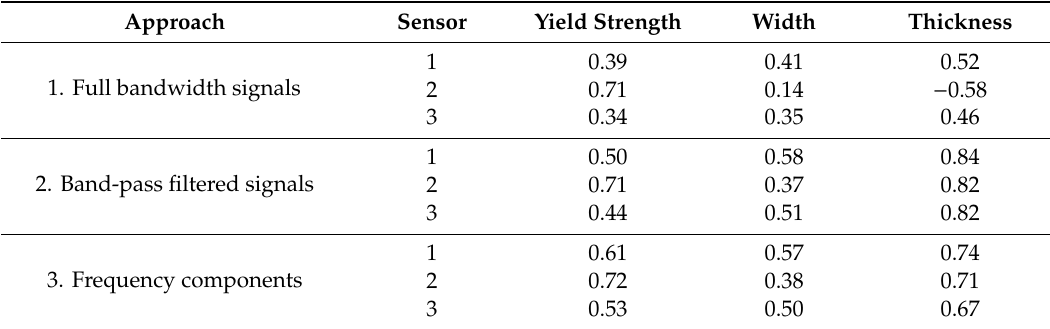
Table 4. Strongest correlations between features and steel strip properties.